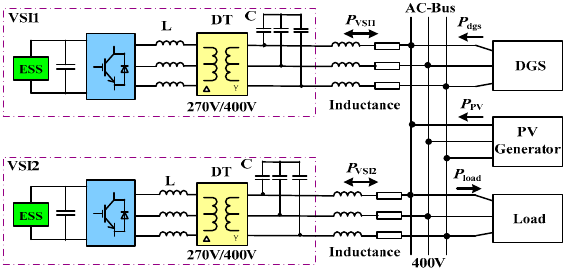
Figure 1. Typical structure of an autonomous photovoltaic (PV)–battery–diesel microgrid.